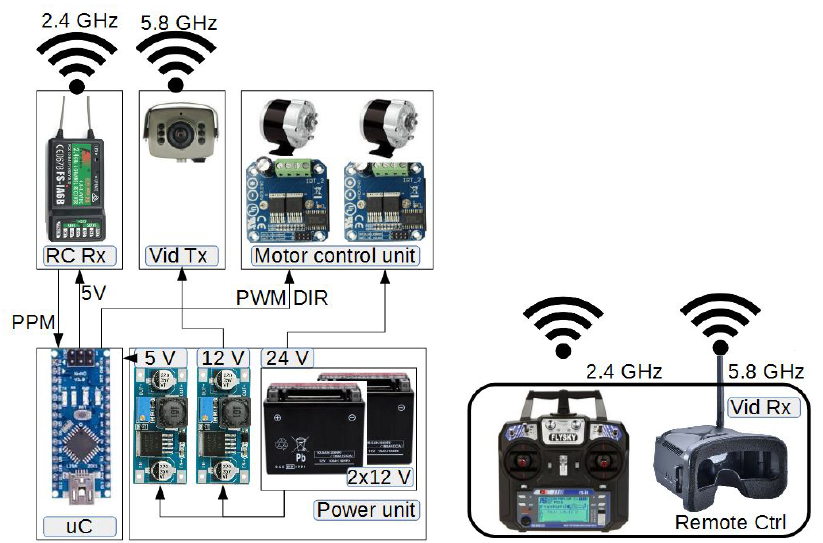
Figure 2. Mobile platform control